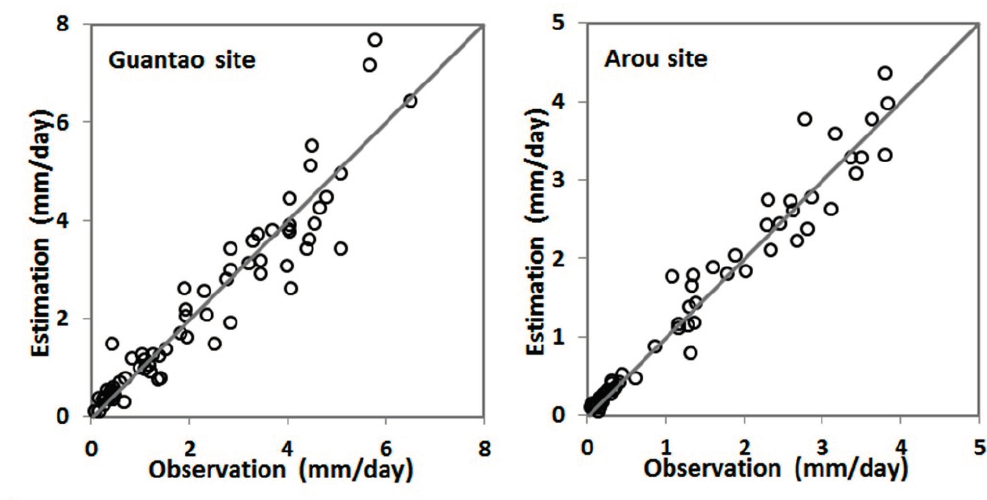
Figure 4. The comparisons of clear-sky ET estimates from the optimum method with in situ observations.